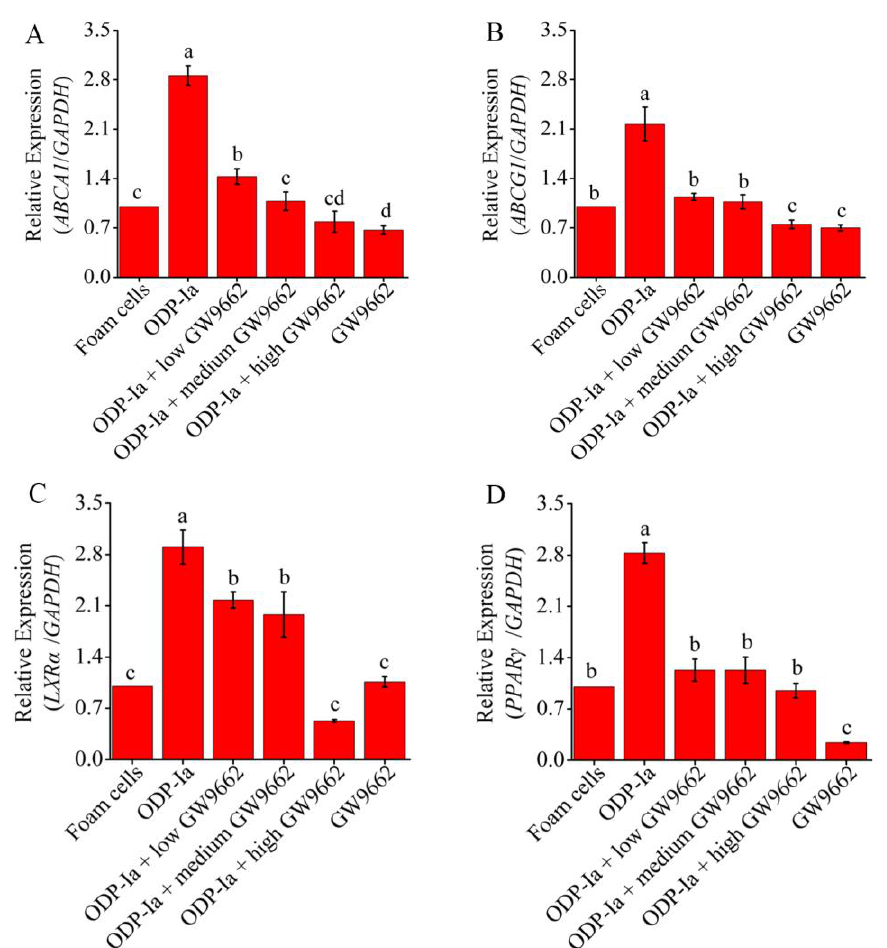
Figure 9. mRNA expression of cholesterol efflux associated gene mediated by GW9662 and ODP-Ia. (mean ± SD, n = 3). ( A ) ABCA1 mRNA. ( B ) ABCG1 mRNA. ( C ) LXRα mRNA. ( D ) PPARγ mRNA. Different superscript letters indicate multiple comparisons with significant differences (SNK-q test, p < 0.05).